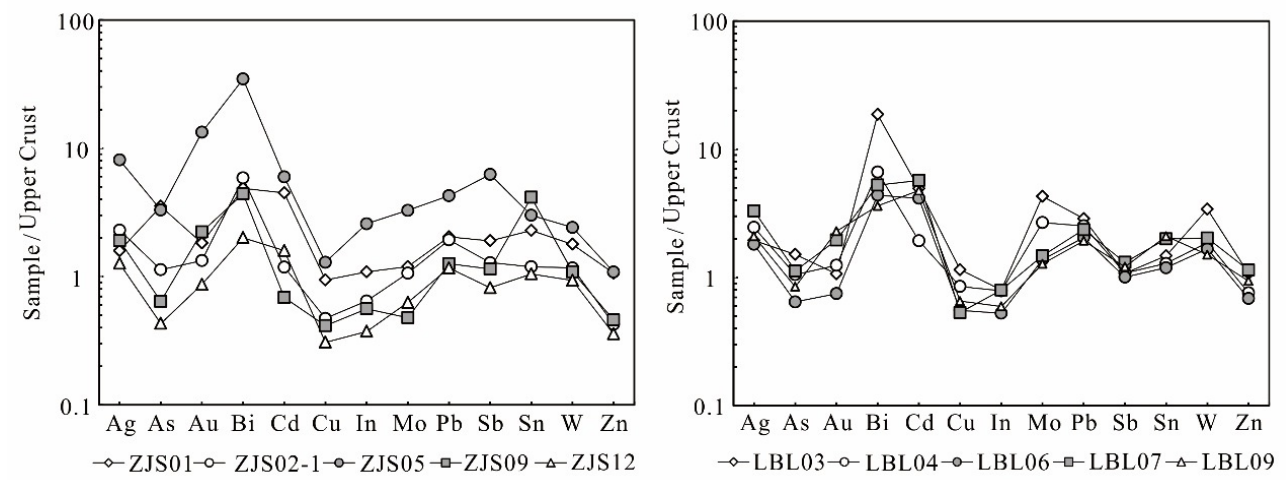
Figure 8. Normalized patterns of ore-forming elements of stream sediments in the Zijinshan Copper-Gold Orefield. Upper Crust normalized data are from [56].